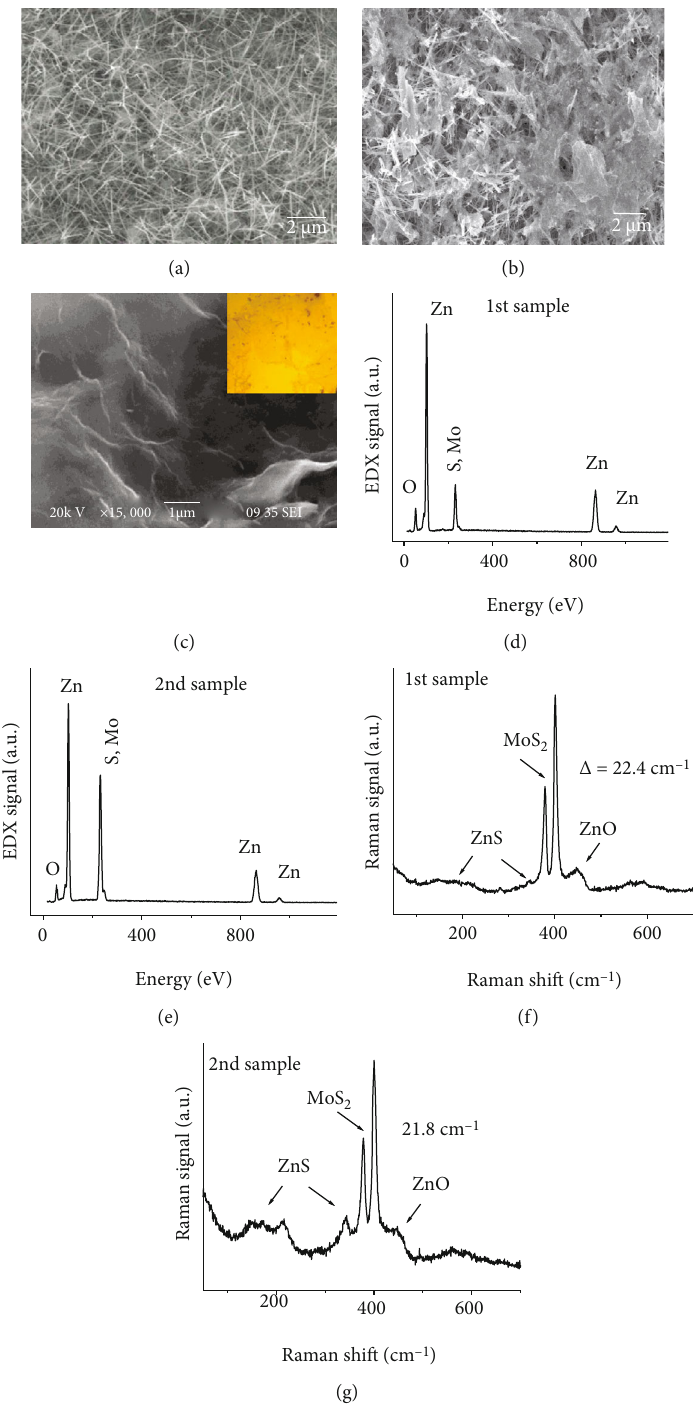
Figure 1: (a, b, c) Typical SEM images of nanostructured ZnO, ZnO-MoS (d, e) EDX and (f, g) Raman scattering spectra of ZnO-MoS